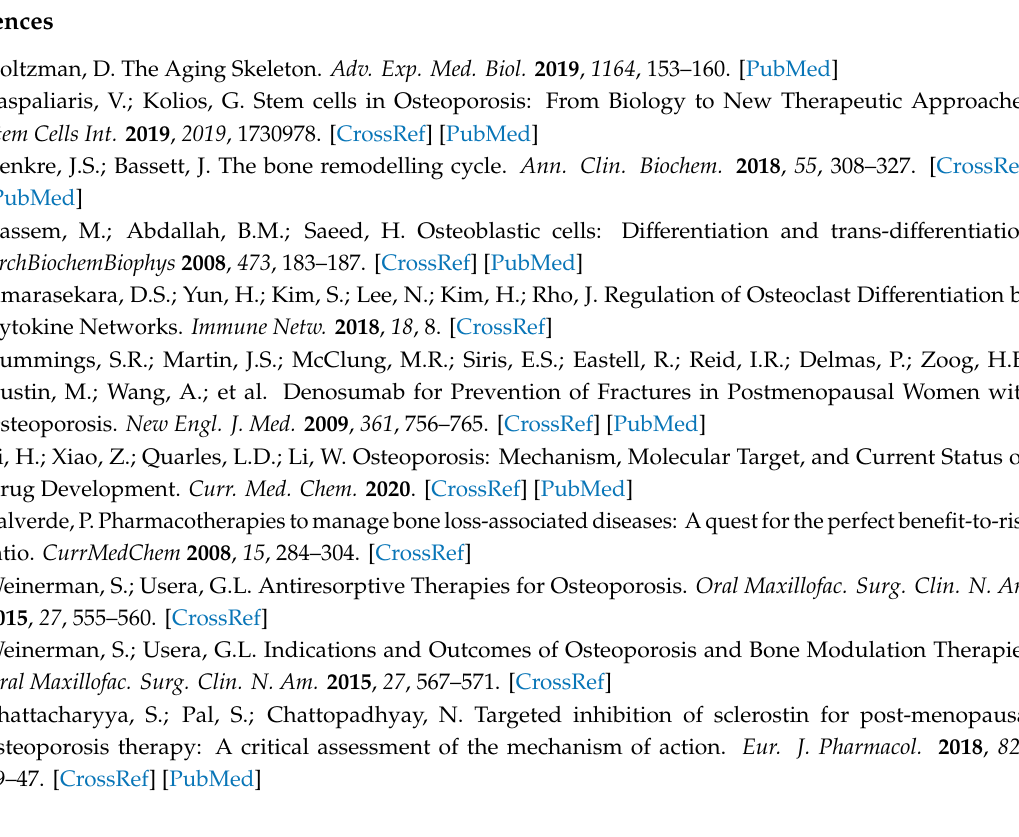
Supplementary Materials: Table S1: List of primers used for